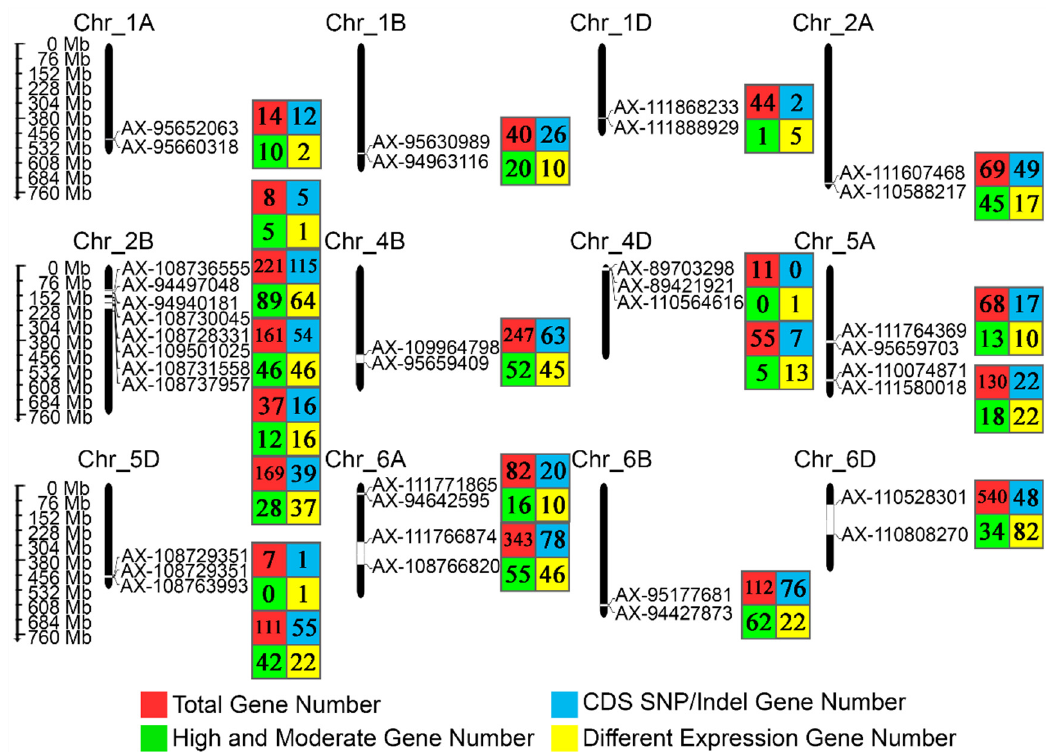
Figure 6. The SNP/InDel variations and DEGs identified on the 20 large-effect quantitative trait loci (QTLs) associated with abiotic stress responses in wheat. The boundaries of the chromosomal positions of the 20 QTLs are indicated by marker identifiers of the wheat 660 k array according to their physical location. The total annotated gene number, number of genes with SNPs/InDels on their CDS regions, the number of genes carrying high- and moderate-effect variations, and the number of DEGs on the loci are indicated by red, blue, green, and yellow squares, respectively.